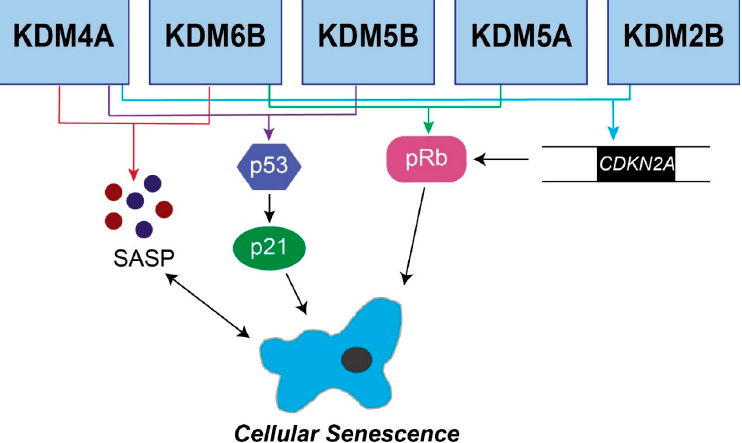
Figure 1. Senescence pathways regulated by JmjC demethylases. The five JmjC demethylases shown are known to affect senescence through the p16/pRb pathway, the p53/p21 pathway, or the senescence-associated secretory phenotype. KDM6B, KDM5B, KDM5A, KDM4A, and KDM2B have all been shown to regulate CDKN2A , which feeds into the pRb pathway. Additional